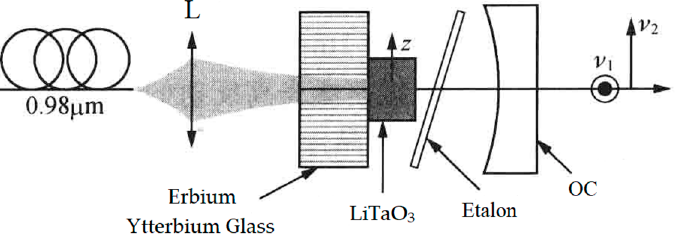
Figure 15. Schematic diagram of dual-frequency erbium–ytterbium glass laser [27]. L: lens; OC: out- put coupler.